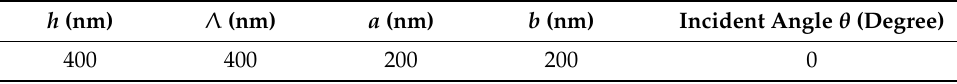
Table 1. Value of the Geometric Parameter Shown in Figure